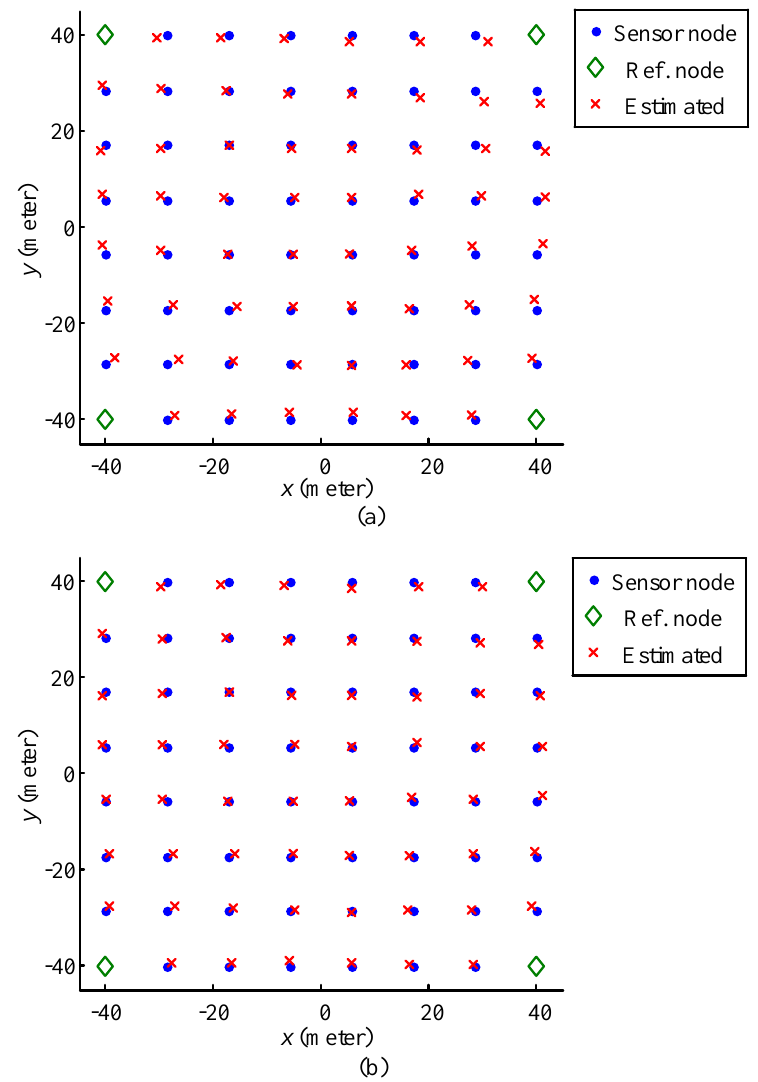
Figure 7. Actual locations of the deployed sensor nodes and the reference nodes, as compared to the estimated locations of the sensor nodes with (a) one rotation cycle and (b) two cycles of the antenna on the reference